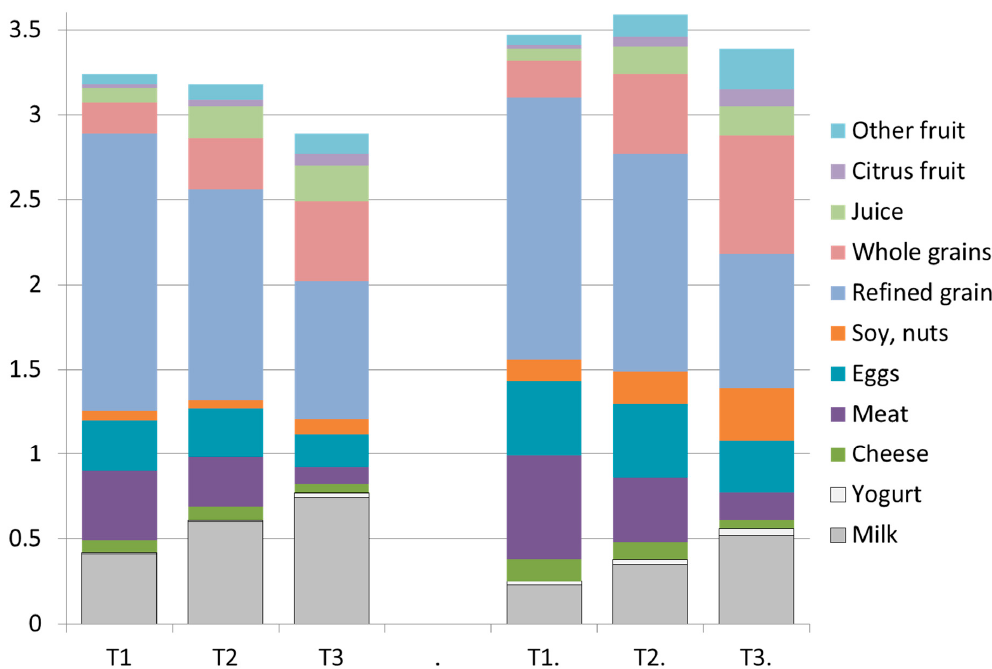
Figure 1. Composition of breakfasts associated with the bottom (T1), middle (T2), and top (T3) tertiles of dietary nutrient density NRF9.3 scores. Data are presented separately for breakfast consuming children (left) and for adults (right) for NHANES 2011–2014. The Y axis shows MyPlate units (cup equiv and / or ounce equiv).